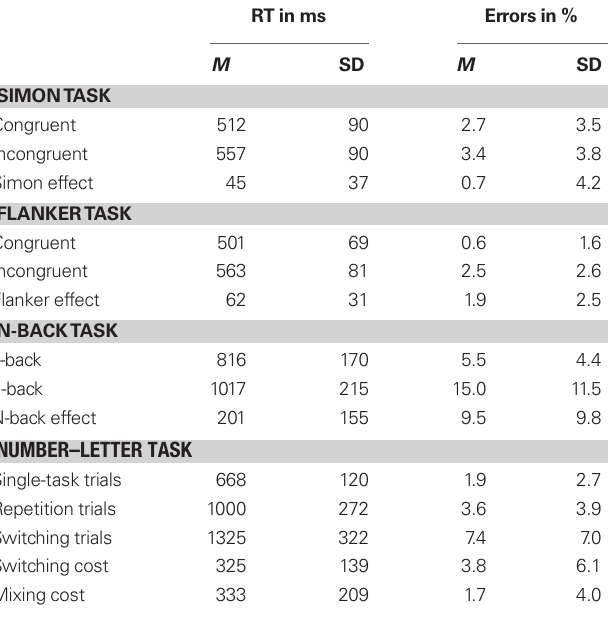
Table 3 | Performance on the executive